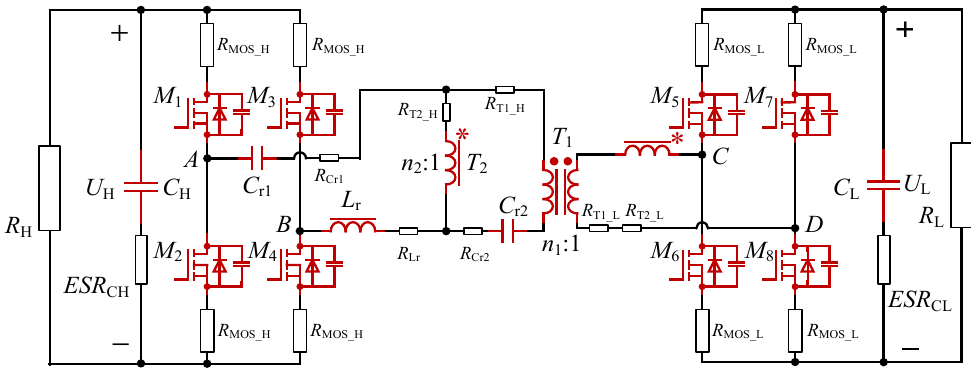
Figure 5. Simulation model for DHC-LT BDC (The symbols of “*” are dotted terminals of T 2 ).